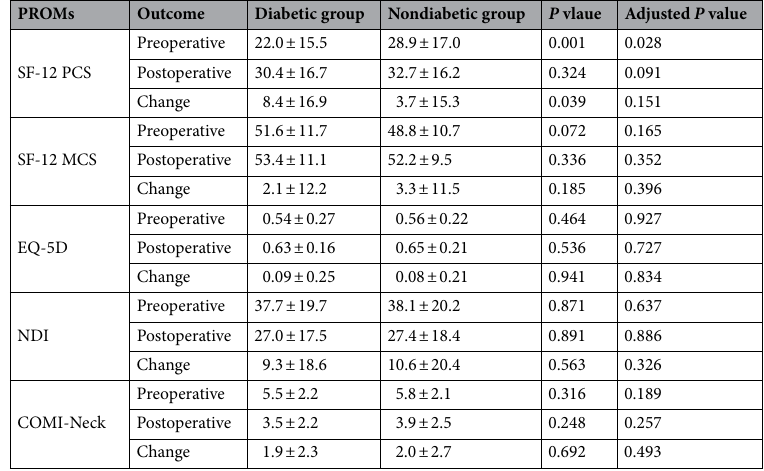
Table 4. Comparison of preoperative and postoperative patient reported outcome measures for patients with diabetes and those without diabetes. PROM patient reported outcome measure, SF-12 the Short Form-12, PCS